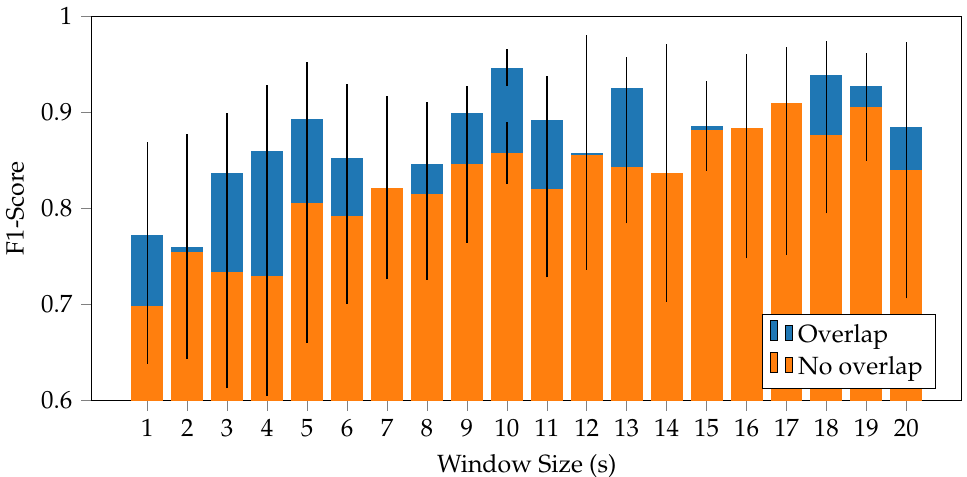
Figure 2. Result of the grid search strategy to identify the optimal sliding window size for classifica- tion. The 10 s window size with 50% of overlap achieved the highest F1-Score (94.64%). Overall in almost all the window sizes tested, the introduction of the overlapping between consecutive windows allowed an increase in the classification